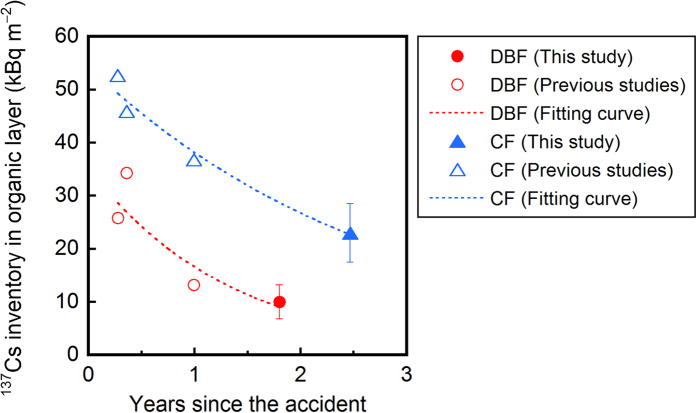
Temporal changes in the 137Cs inventory in the organic (L + F) layers of the two contrasting forests since the Fukushima NPP accident.The data are decay-corrected to the sampling date. Previous studies were conducted in June 201129, July 201130, and March 2012 (Koarashi et al., unpublished).